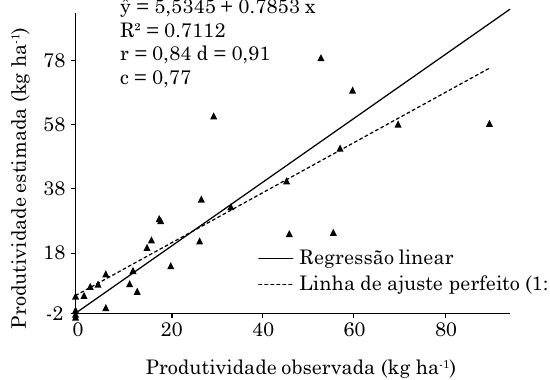
Figura 2. diagrama de dispersão das amostras da produtividade do capim dourado observada (eixo X) e a estimada (eixo Y) estabelecida pelo modelo proposto para o Parque estadual do Jalapão. (R 2 : coeficiente de determinação; r: coeficiente de correlação de Pearson; d: coeficiente de Willmott; e c: índice de